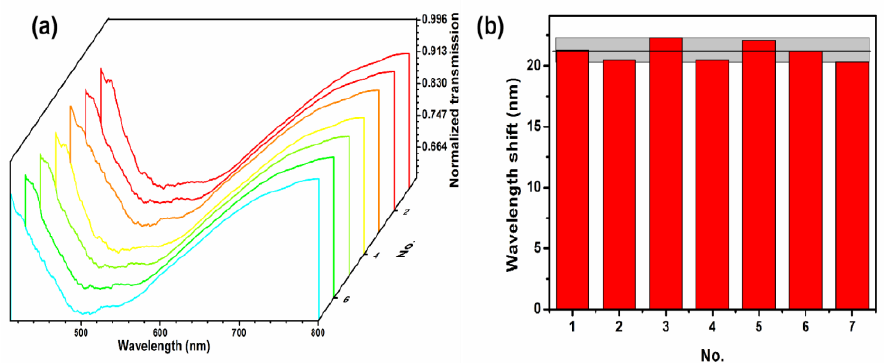
Figure 7. ( a ) The absorption spectra of Gr/ITO-NM/U-bent-A/0.04/20 from 7 different sensors in alcohol solution with RI 1.3330. ( b ) Wavelength shift histogram of different sensors.